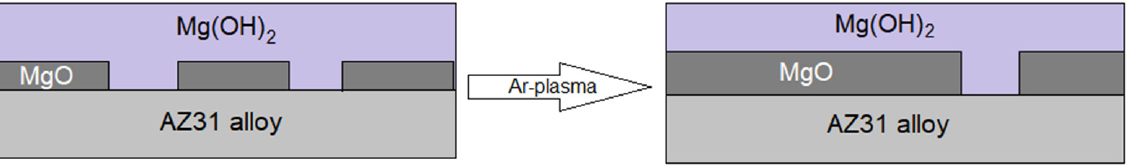
Figure 11. Schematic illustration of the cross-section view of the oxide/hydroxide film formed on the AZ31 alloy surfaces, before and after the pretreatment.